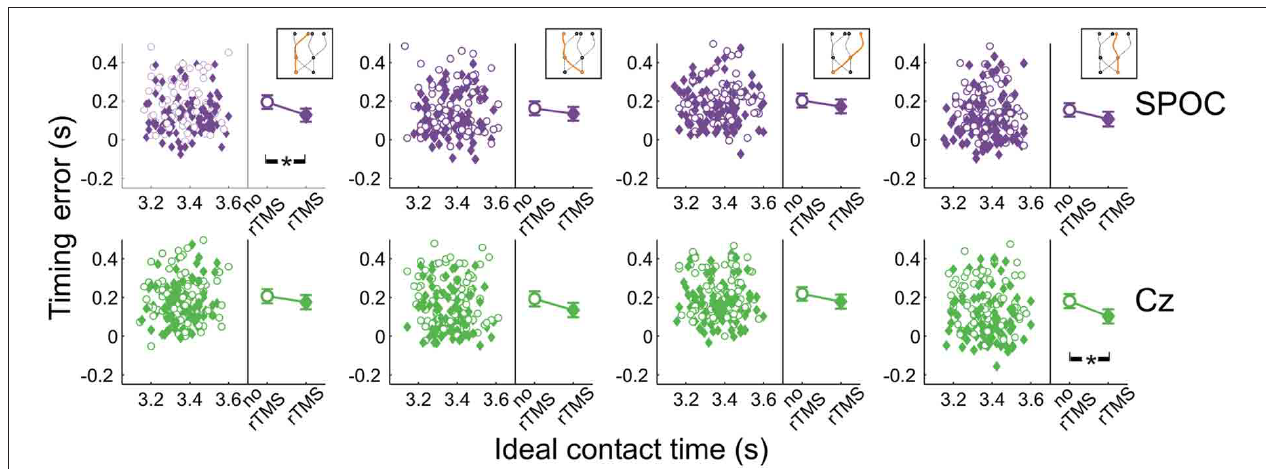
FIGURE 8 | Temporal interception errors for SPOC and its control site Cz for all four trajectory types. In the left part of each panel individual errors are shown as a function of the ideal contact time (trials with rTMS: solid symbols; trials without rTMS: